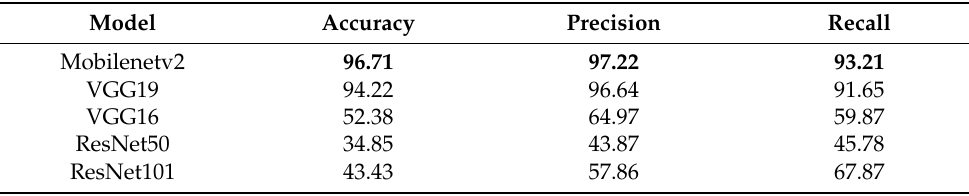
Table 6. Proposed technique classification performance (%).